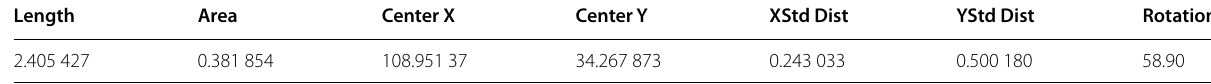
Table 3 Calculation results of standard deviation ellipse Length